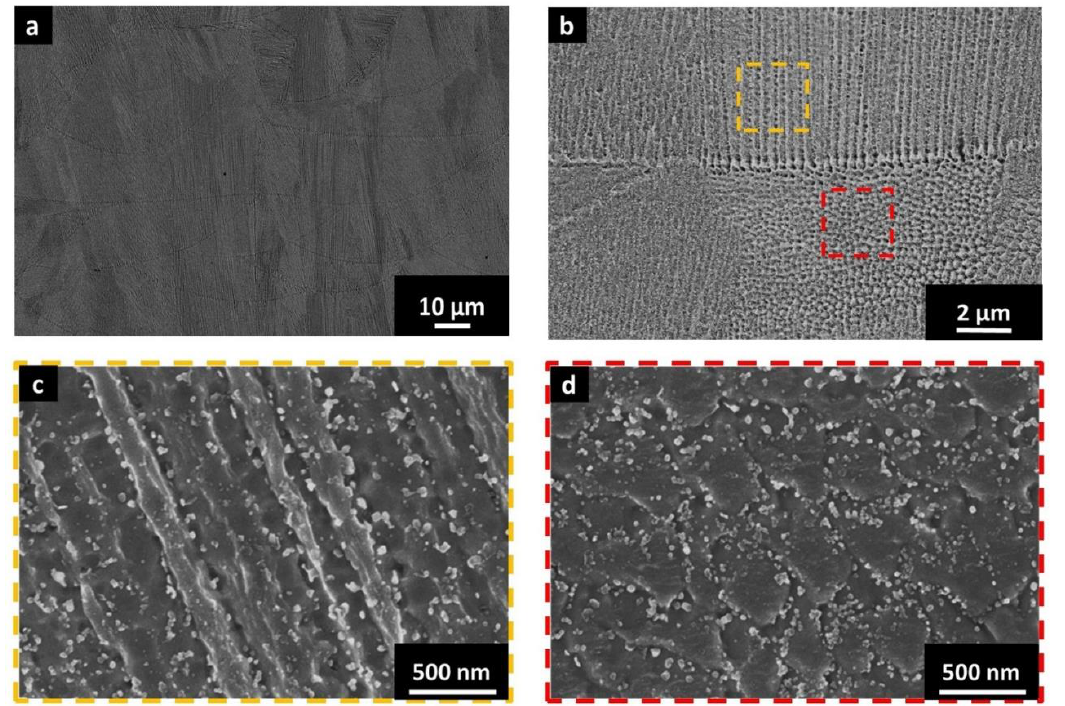
Figure 10. ( a , b ) SEM images of the LPBFed IN939 showing the melt pools; ( c , d ) High-magnification SEM images showing fine dendritic/cellular architectures. Kalling’s No.2 etchant was used.